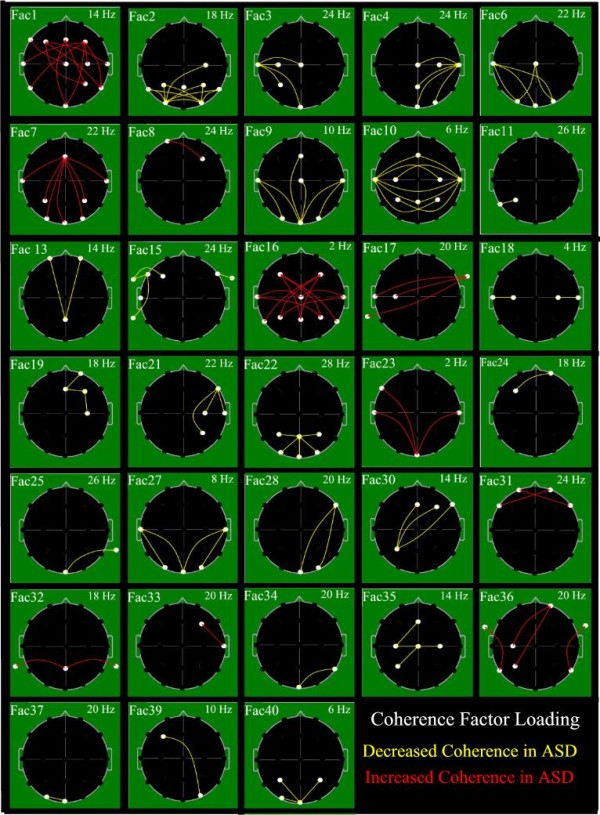
Graphic representation of 33 coherence factor loadings. EEG coherence factor loadings. Heads in top view, scalp left to image left, nose above; Factor number is above heads to left and peak frequency for factor in Hz is above to right. Lines indicate top 15% coherence loadings per factor: Red = increased coherence in ASD-group; Yellow = decreased coherence in ASD-group. Involved electrodes shown as small white circles. Uninvolved electrodes are not shown.